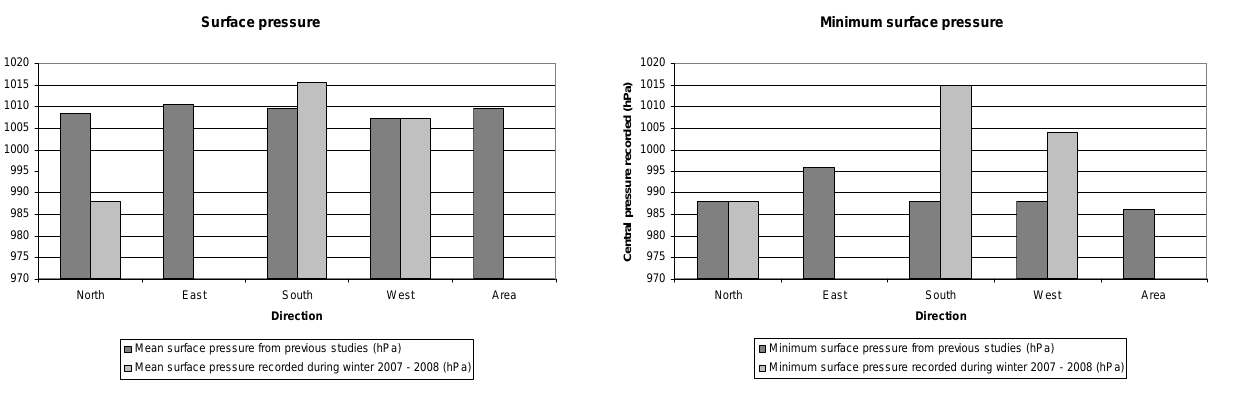
Fig. 2. Comparison between the mean sea level pressure of the clusters in the study period against long term mean.